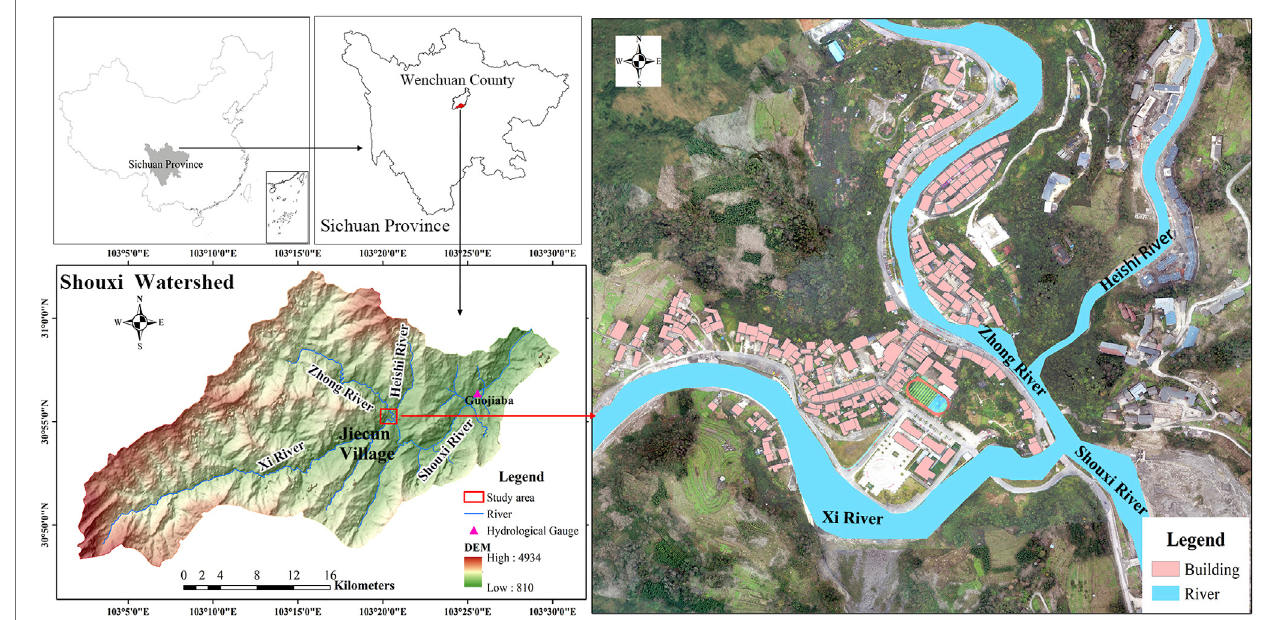
FIGURE 1 | Location of the Jiecun village and the distribution of buildings in the area.